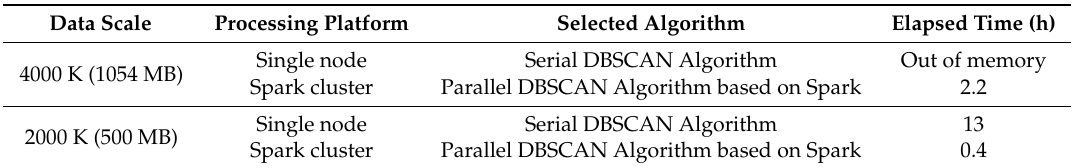
Table 15. Processing time comparison of the serial algorithm and the parallel algorithm with different data